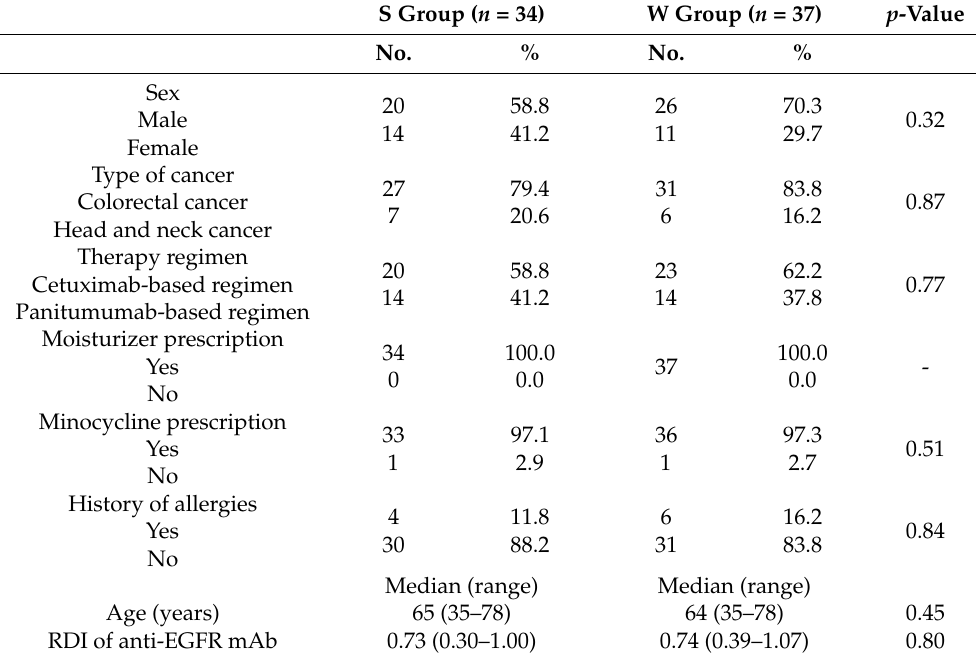
Figure 2. Consolidated Standards of Reporting Trials diagram for the study. S group, patients who received treatment in summer (June to August); W group, patients who received treatment in winter (December to February). Table 1. Patient characteristics.